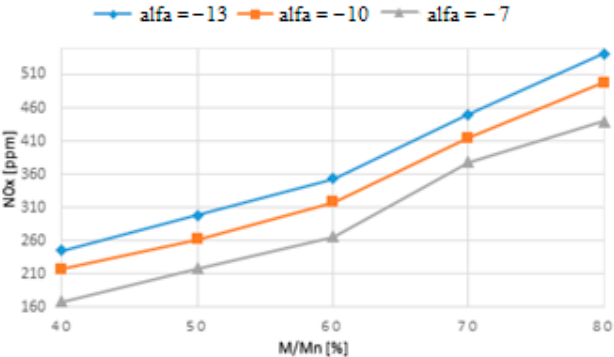
Figure 7. NO x content in exhaust as a function of the engine load and three different advance angles of fuel injection, for a constant rotational speed n = 220 rpm.